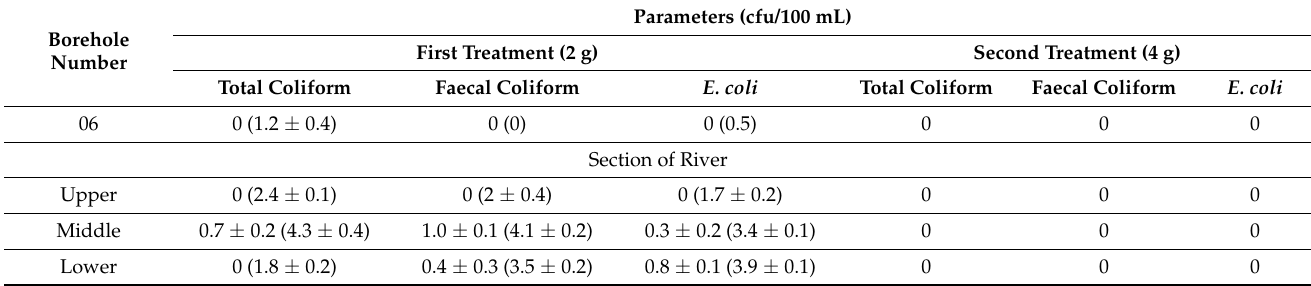
Table 5. Effectiveness of sunflower seed extract on the three selected bacteria during summer